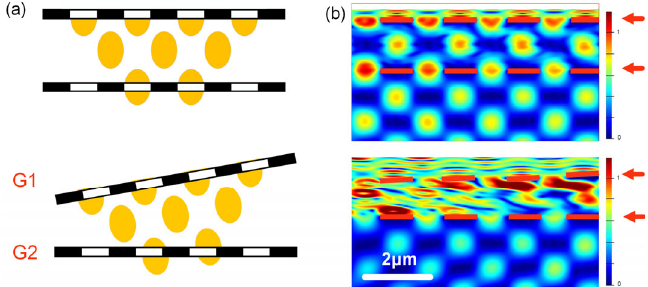
Figure 4. ( a ) Schematic diagrams of the simulated figures with θ = 0° and θ = 2°, respectively. ( b ) Transmission light of a two ‐ grating structure consisting of two optical microgratings with a different θ of G1. The positions of the two gratings are indicated by the red arrows.